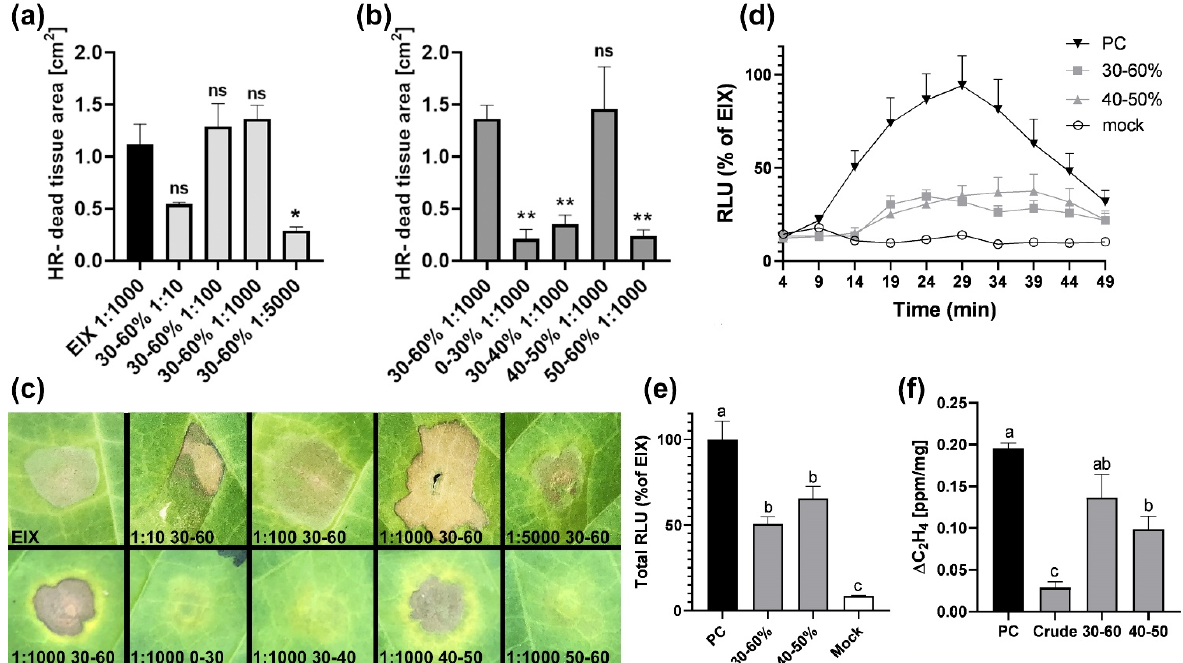
Figure 4. Elicitation of plant defense responses by purified Ethylene Inducing Xylanase (EIX) fractions. ( a – c ) Hypersensitive Response. Leaves of tobacco plants were injected with ( a ). Serial dilutions of fraction 30–60%. ( b ) Equal amounts of different fractions as indicated. ( c ) HR development was photographed 72 h post injection. Quantification of results from two biological repeats ±SE, n ≥ 3. Asterisks (differences between positive control and treatment) indicate significance in one-way ANOVA with a Bonferroni post hoc test, * p < 0.05, ** p < 0.01, ns = non-significant. ( d , e ) Reactive oxygen species measurements. Leaf disks of M82 plants were floated on water overnight and then replaced with luminescence solution containing indicated purification fractions. Luminescence (RLU) was immediately measured to track the ROS burst. Average ± SEM values of three independent experiments, n = 12 each. ( d ) kinetic graph. ( e ) Summary of total RLU. Letters represent significant differences (one-way ANOVA, p < 0.01). ( f ) Ethylene biosynthesis. Leaf disks of 5-week old tobacco plants were floated overnight on a 250 mM of sorbitol solution with indicated fractions. Ethylene induction was defined as the Δ Ethylene (Treatment Ethylene –Mock Ethylene ). Error bars represent the average ± SEM of three independent experiments, letters represent significant differences ( n = 21, one-way ANOVA, p < 0.05).